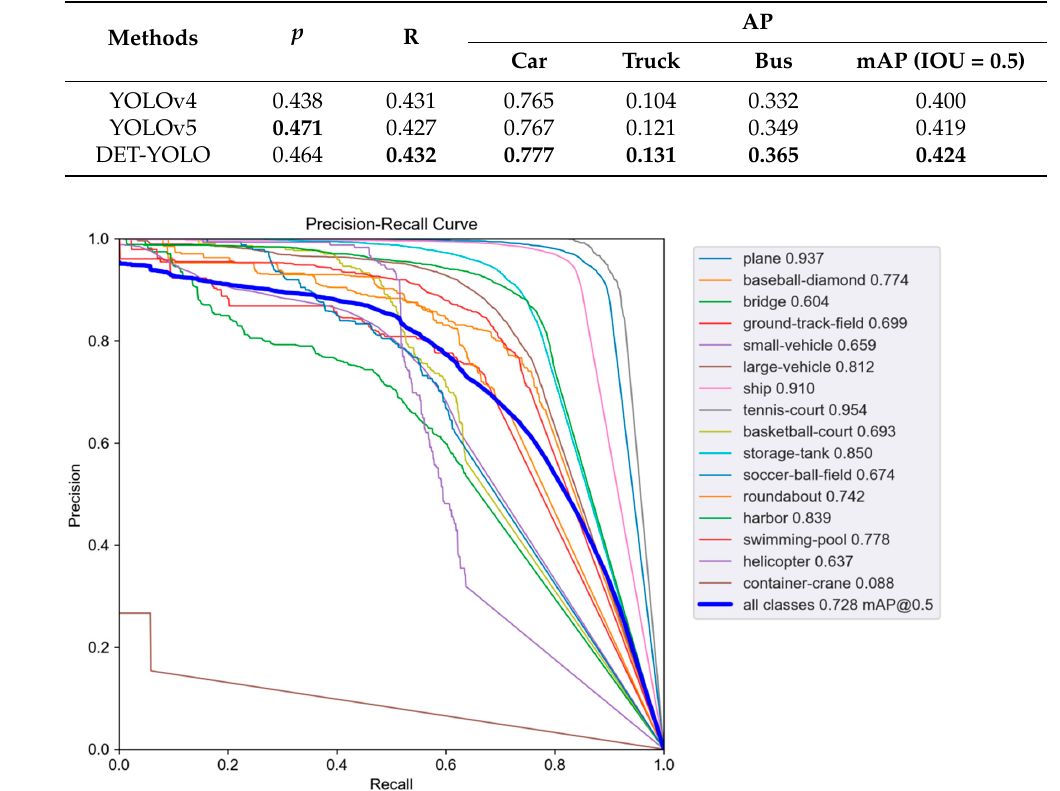
Figure 8. The P-R curve of DET-YOLO on the DOTA dataset at an IoU threshold of 0.45 and a confidence threshold of 0.25.